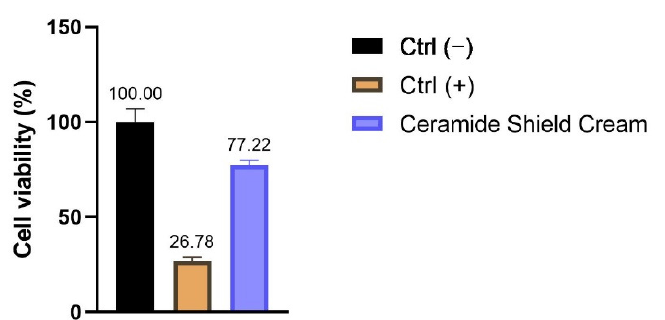
Figure 6. Cell viability expressed as a percentage (%) of HCE treated with Ceramide Shield Cream. Ctrl ( − ): HCE treated with DPBS; Ctrl (+): HCE treated with SDS as the irritating stimulus.